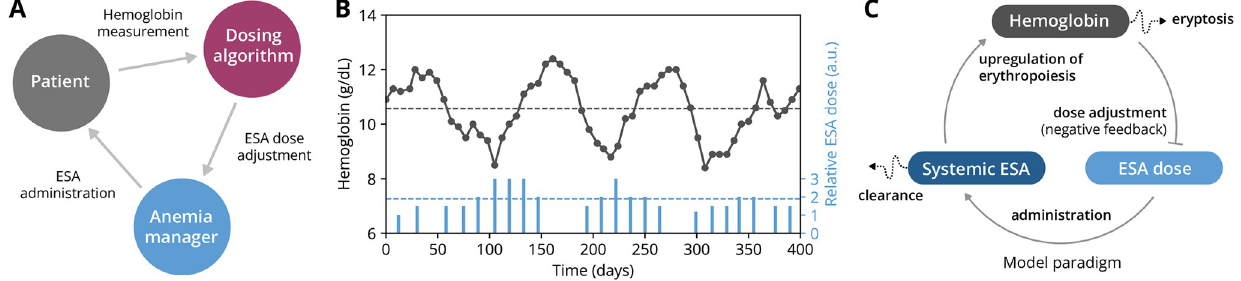
Fig 1. General features of ESA therapy and hemoglobin cycling. (A) Simplified representation of the treatment loop involved in erythropoiesis- stimulating agent (ESA) therapy: An anemic patient’s hemoglobin levels are measured on a regular basis and inform ESA dose adjustments via a dosing algorithm and/or an anemia manager’s decision. The given ESA dose, in turn, affects the patient’s hemoglobin levels. (B) Historical record of hemoglobin (Hb) cycling in an anemic hemodialysis patient showing Hb measurements (dots) and ESA administrations (bars). Dashed lines indicate mean values for the respective quantities on the shown time horizon. (C) Schematic depiction of the biomedical model with three variables (Hb levels, current ESA dose prescription and systemic ESA levels) capturing the key features of the feedbacks shown in panel A. The model is described in detail in the Methods section.